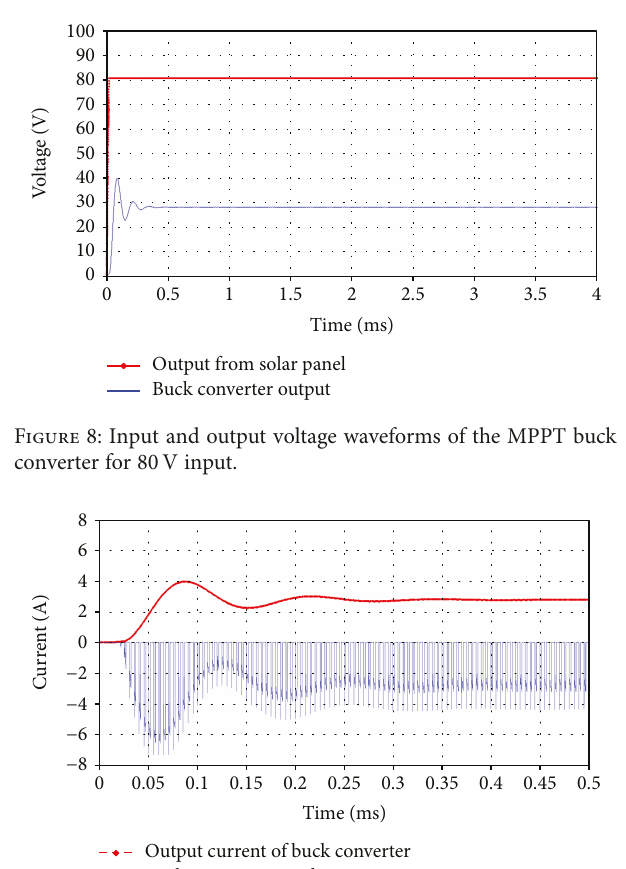
Figure 12: Waveforms of input and output voltage for 61V input.